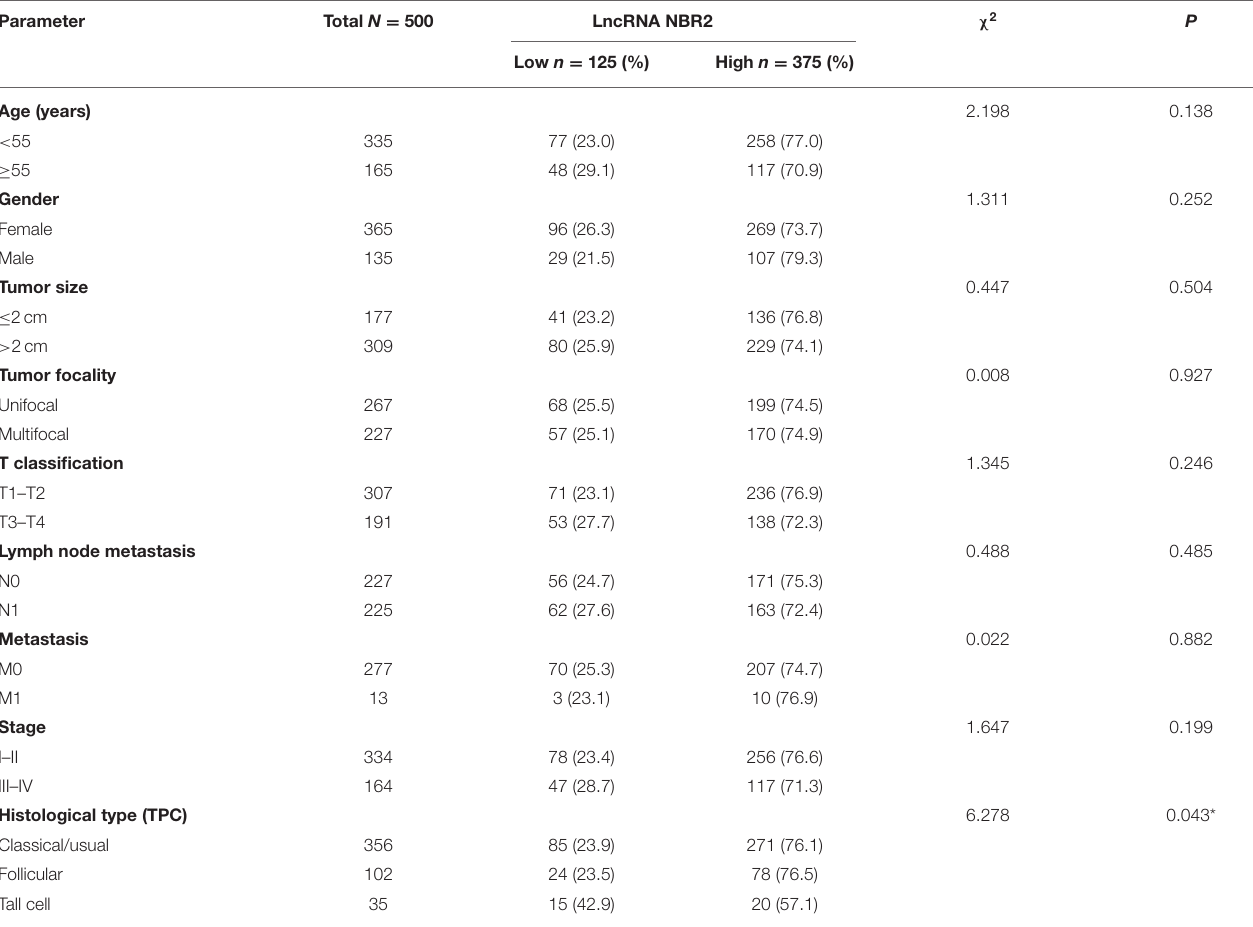
TABLE 1 | Association of lncRNA NBR2 expression with clinicopathologic features in TC patients.